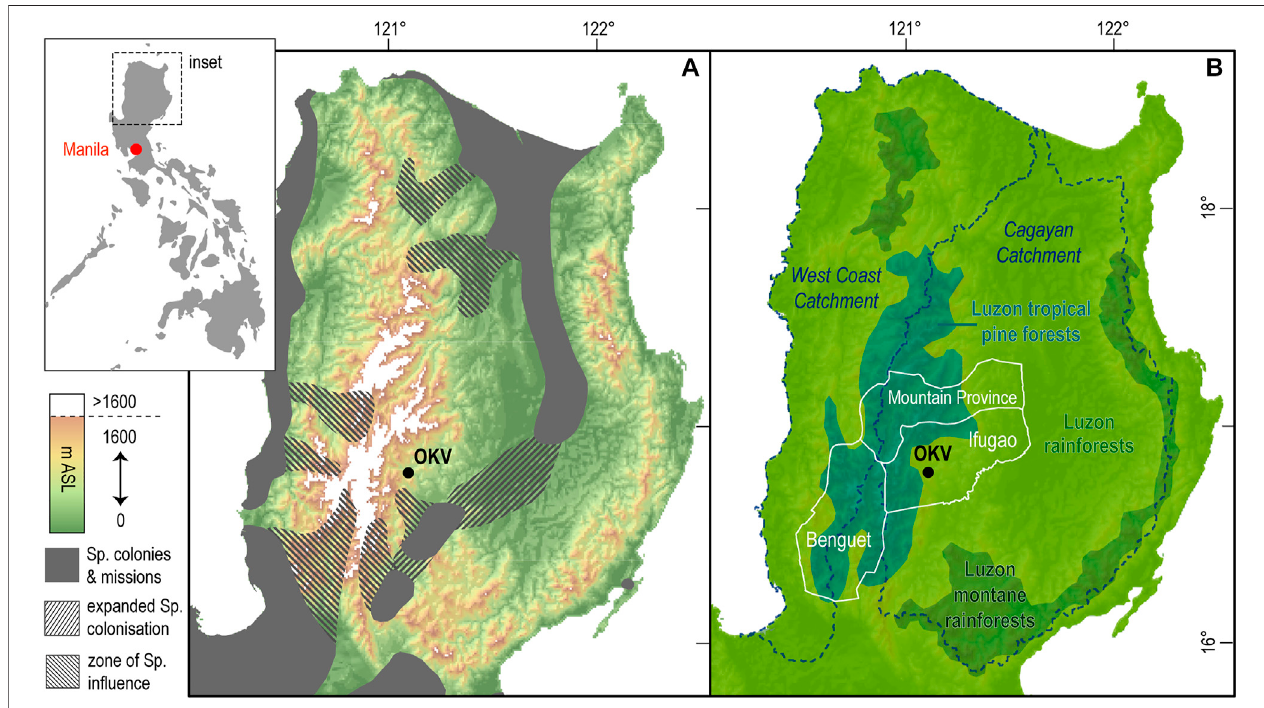
FIGURE 1 | Maps of Northern Luzon detailing (A) topography and the extent of Spanish colonization circa 1780 CE and (B) the outline of modern Ifugao province, the three ecotypes of Northern Luzon, and water catchments. Old Kiyyangan Village (OKV) is identi fi ed in both maps. The extent of Spanish colonization in the 18th century, shown in panel A, is reproduced from Conklin (1980,